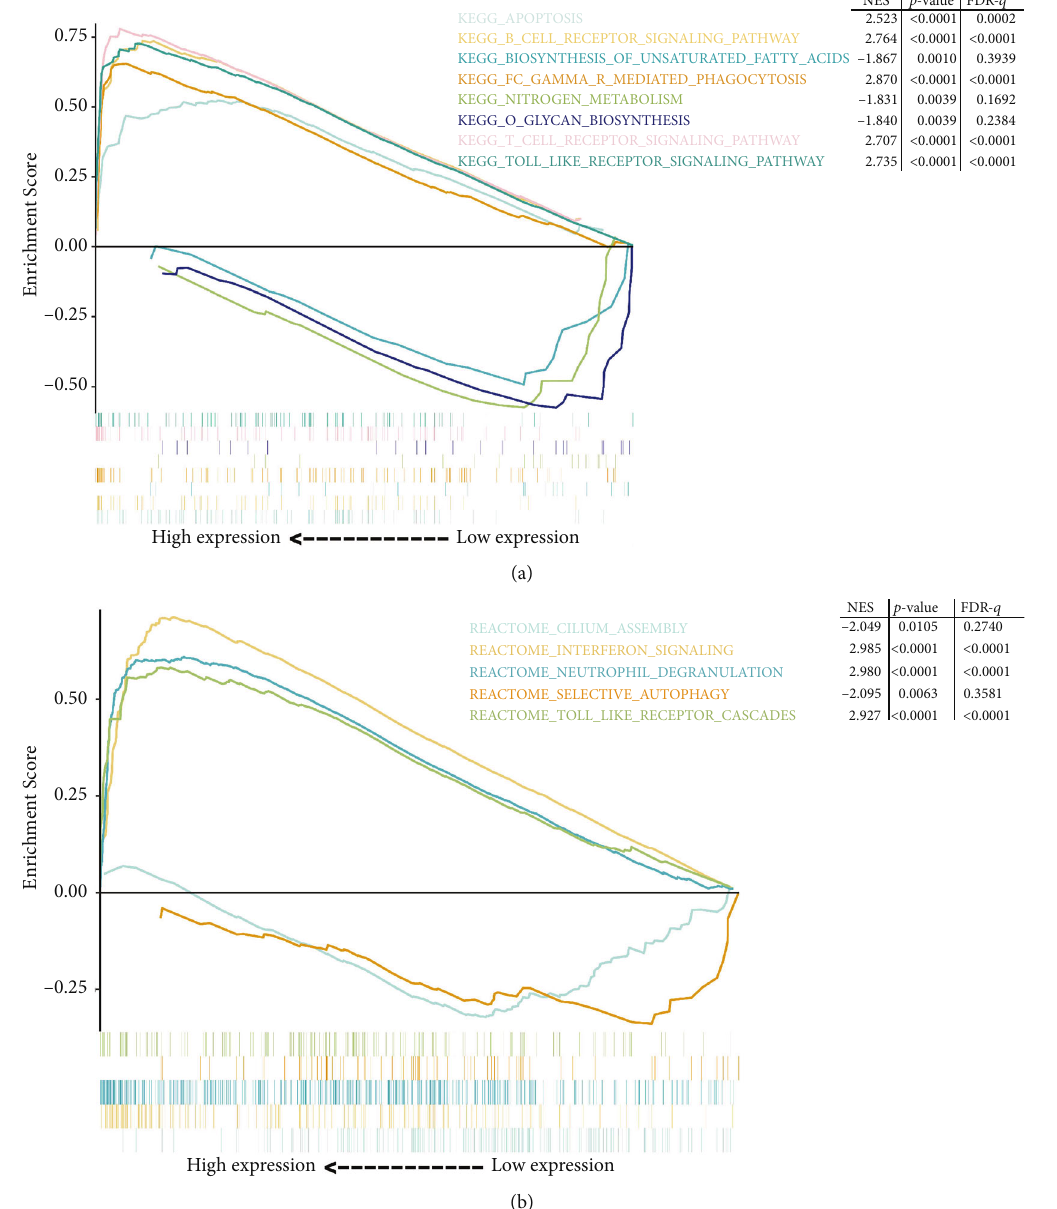
Figure 7: The gene set enrichment analysis with (a) C1QB -related KEGG pathway and (b) C1QB -related reactome